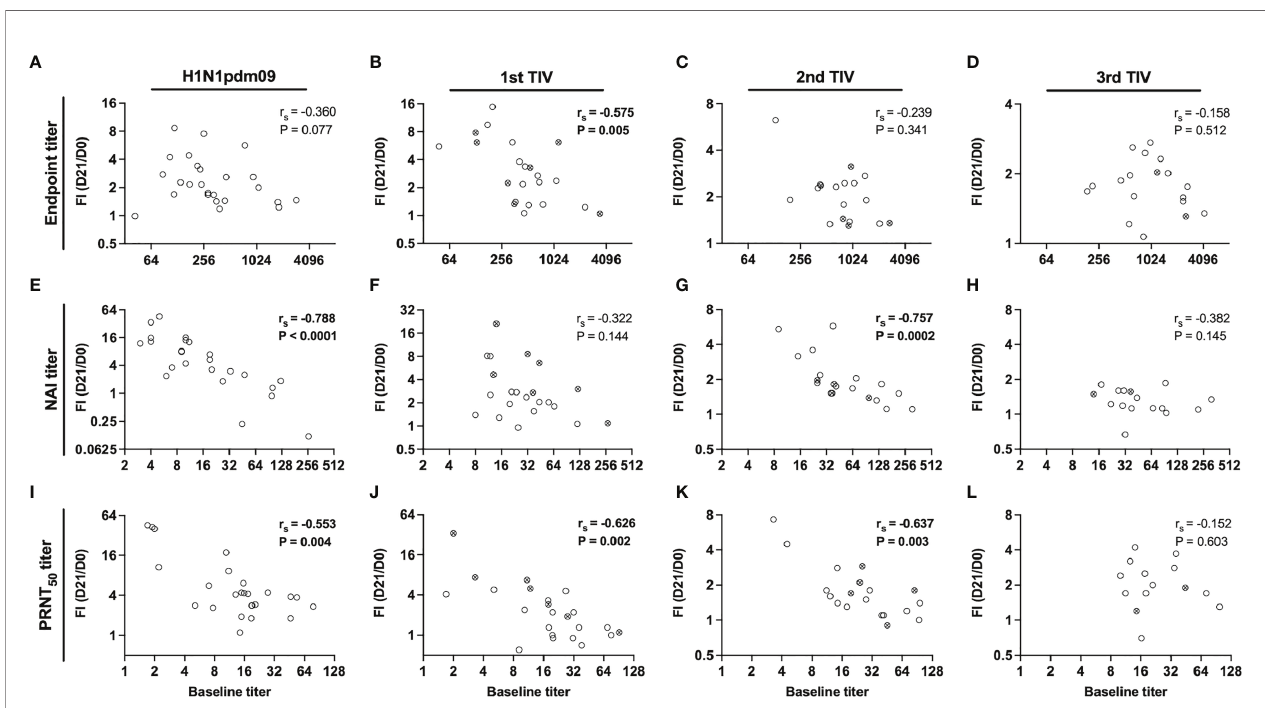
FIGURE 5 | Relationship between pre-existing titers and fold-increase 21 days post-vaccination. Correlation between baseline titers and fold-increase (FI) of titers on day 21 post-vaccination (day 21/day 0) for endpoint (A – D) , NAI (E – H) and PRNT 50 titers (I – L) in the repeated group. Health care workers (HCWs) were vaccinated with H1N1pdm09 and two or three trivalent in fl uenza vaccines (TIVs) during in fl uenza seasons 2009/2010 – 2013/2014. The antibody responses have been grouped by the vaccine number that were administered. All vaccinated HCWs in the repeated group is included in this fi gure regardless of their vaccination intervals. Open circles represent HCWs that were vaccinated the previous season and crossed circles represent HCWs that had chosen to not be vaccinated the previous season. The correlation coef fi cient (r s ) was calculated by non-parametric Spearman